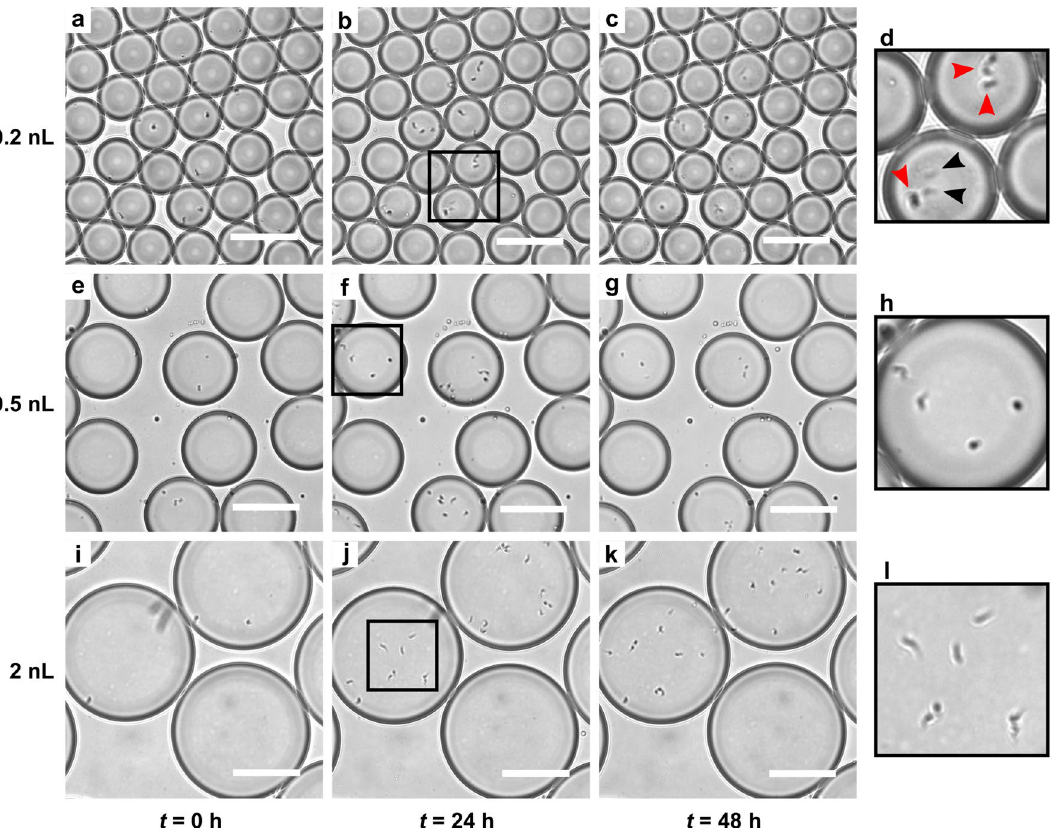
Figure 2. Impact of drop size on trypanosome survival. The figure display snapshots of encapsulated T.b. brucei cells just after encapsulation, after 24 h of incubation and after 48 h of incubation in drop sizes of 0.2 nL ( a–c ), 0.5 nL ( e–g ) and 2 nL ( i–k ), visualized in incubation chamber through a x10 microscopic objective. Examples of living cells (red arrows) and dead cells (black arrows) are seen in the close-up snapshot ( d ) at 24 h. In the snapshots ( h , l ) all cells are alive. All scale bars are 100 µ m. For snapshots a–c , e–g and i–k , the corresponding original movies, showing survival based on motion of the trypanosomes, are provided as supplementary (Movie surfactant pinching the cell suspension flow creating equal sized microcompartments in the form of drops (Fig. 1b, Fig. S2a). The flow rates of the oil and cell suspension together with the dimension of the nozzle in the respective devices are controlling the drop sizes to reach final drop volumes V drops of 0.2 nL ±1.80 % , 0.5 nL ±1.84 % and 2 nL ±2.61 % . For incubation, the drops are collected in an incubation chamber stabilizing the drops in a monolayer display allowing the exact same drops to be analysed over periods of time, as described previously (Fig. 1c) 25 . The incubation chamber is connected to the outlet of the encapsulation device by external tubings and has a volume of approximately 18 µ L (Fig. S2b). One incubation chamber therefore provides multiplex meas- 4 urement of over 10 droplets. After filling, the incubation chamber is detached from the encapsulation device and completely sealed enabling the transfer of the chamber to a cell incubator or a microscope when needed. In order to investigate cell survival upon isolation, we optimized the number of drops containing only single cells, while keeping the number of drops containing more than one cell at a minimum, by dilution of the encap- 5 sulated cell suspensions (in the range C = 0.875 − 8.750 · 10 cells/mL). The cells being randomly distributed in − (cid:31) / n ! the bulk suspension, the cell distribution is expected to follow a Poisson distribution: f( (cid:31) ; n ) = (cid:31) n e , where n is the actual number of cells in the drops and (cid:31) is the average number of cells per drop 23 . (cid:31) relates directly to the cell density C in the culture as C = (cid:31) / V drops . Using an occupation factor (cid:31) = 0.175, we recover cell distribu- tions consistent with a Poisson distribution for the three sizes of drops (Fig. 1d). We obtain ∼ 11–15% drops containing single cells in drop sizes of 0.2 nL, 0.5 nL and 2 nL. For all three sizes, less than 1.5% of drops contain more than one cell. In few of the drops we observe a cluster of several cells clumping together (Fig. 1d), referred to as clumps (C). This is a common event in in vitro cultures when populations are reaching high cell densities. Except for these rare events, the encapsulation of trypanosomes is reliable and equivalent to the encapsulation of any type of particles randomly distributed in the initial volume. Survival and growth of T.b. brucei in drops. We first determine the survival of cells in droplets as a function of droplet sizes (Fig. 2, supporting Movie S1–S6). Droplets containing cells are collected in the incuba- tion chamber in which 200–400 cell-containing drops are counted. All counting experiments are performed in triplicates for each experimental condition. The cells are counted directly from the incubation chamber by eye